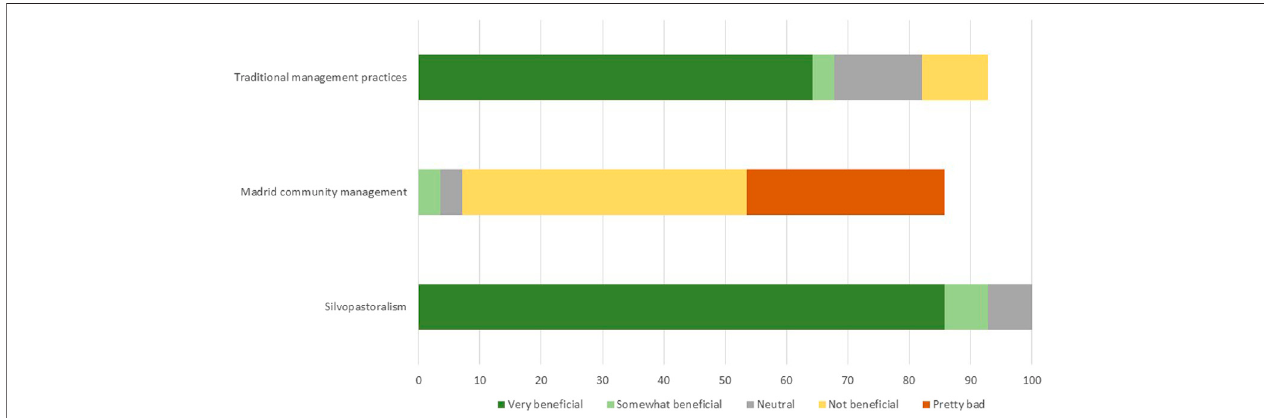
FIGURE 3 | Perception of different management practices ’ impacts on woodlands by local people from La Puebla de la Sierra. Upper graph: Perception of bene fi t from diverse traditional management practices as clearing, browsing, pruning etc.; Middle graph: Perception of bene fi t from management practices used by the Madrid Autonomous Community; Lower graph: Perception of bene fi t from traditional silvopastoralism management.